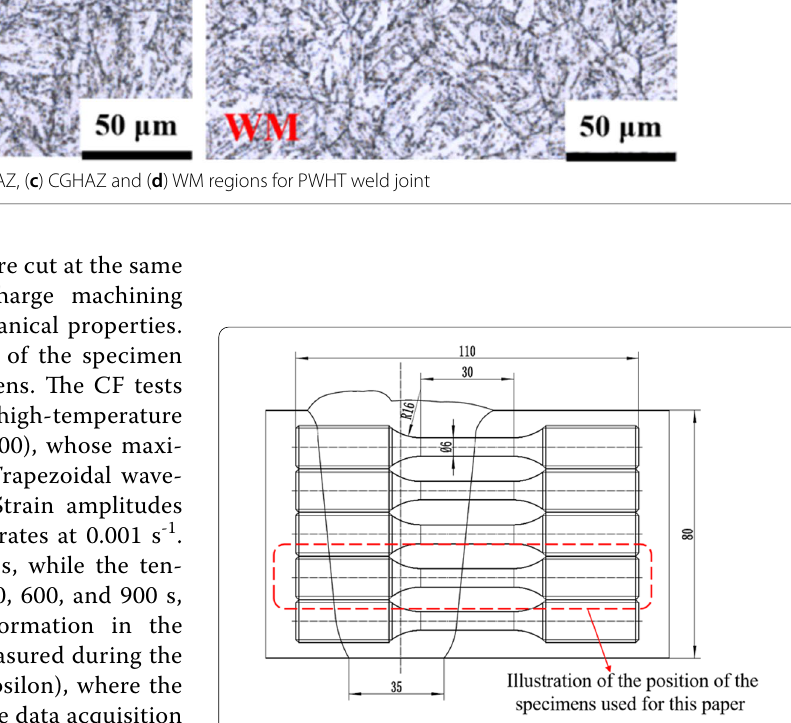
Figure 2 The illustration of the position and geometry of CF specimens from the P92 steel welded